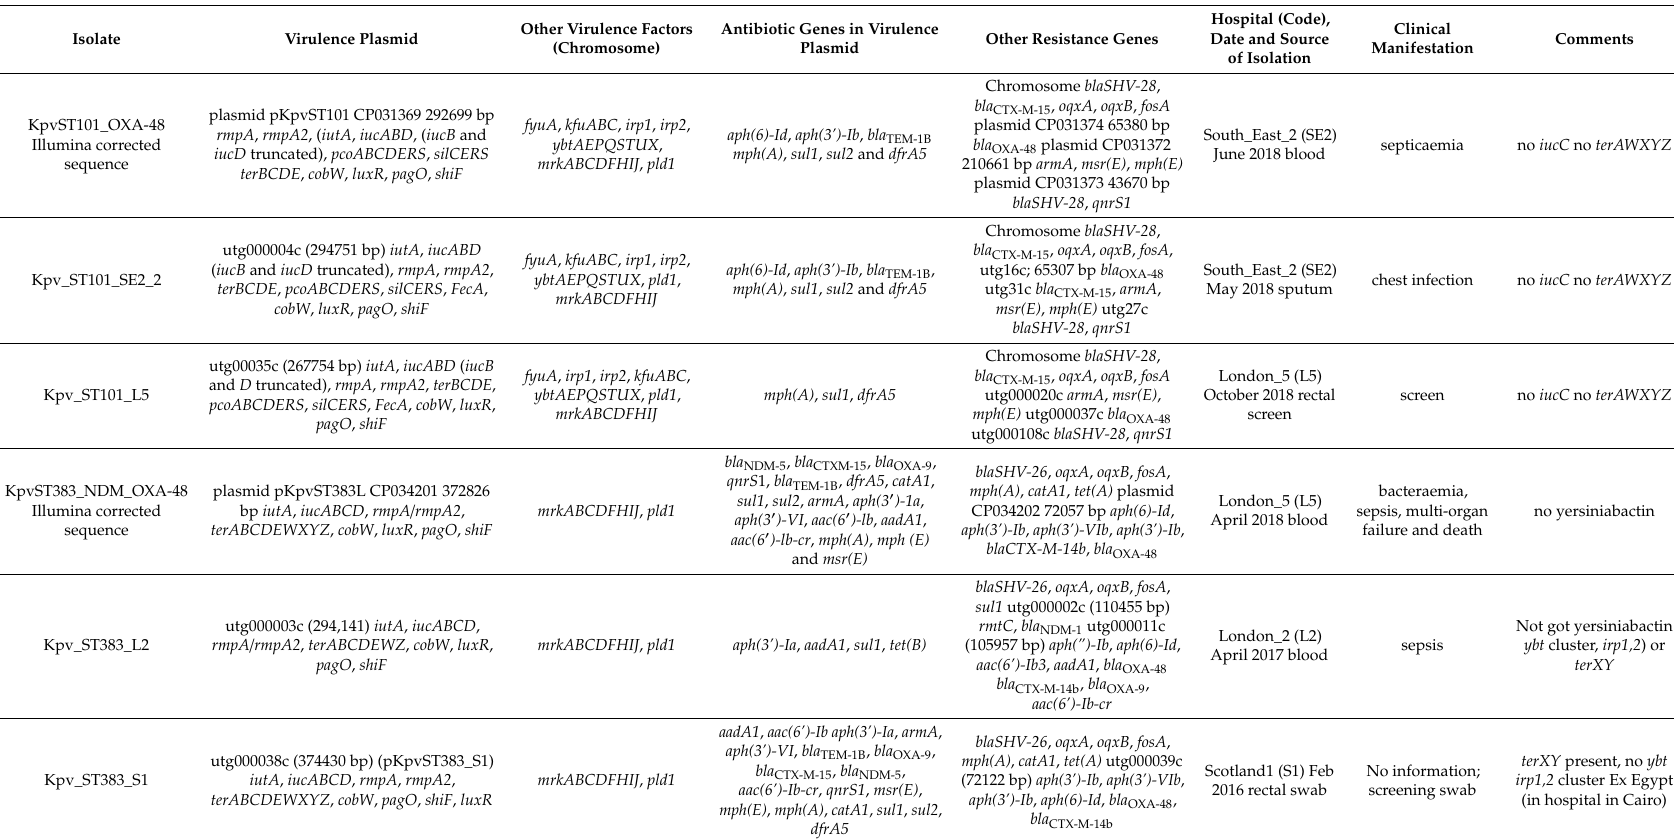
Table 1. Summary of virulence and resistance gene characteristics of thirteen representatives of high-risk clones carrying hybrid virulence / resistance plasmids. All isolates were subjected to nanopore sequencing; six isolates were also subjected to Illumina sequencing, and the Illumina-corrected sequences are described below. Plasmids are described by their GenBank accession numbers or the “utg” contig number from the assembly, ‘c’ after the number indicates a circular contig. Isolate Virulence Plasmid Other Virulence Factors (Chromosome) Antibiotic Genes in Virulence Plasmid Other Resistance Genes